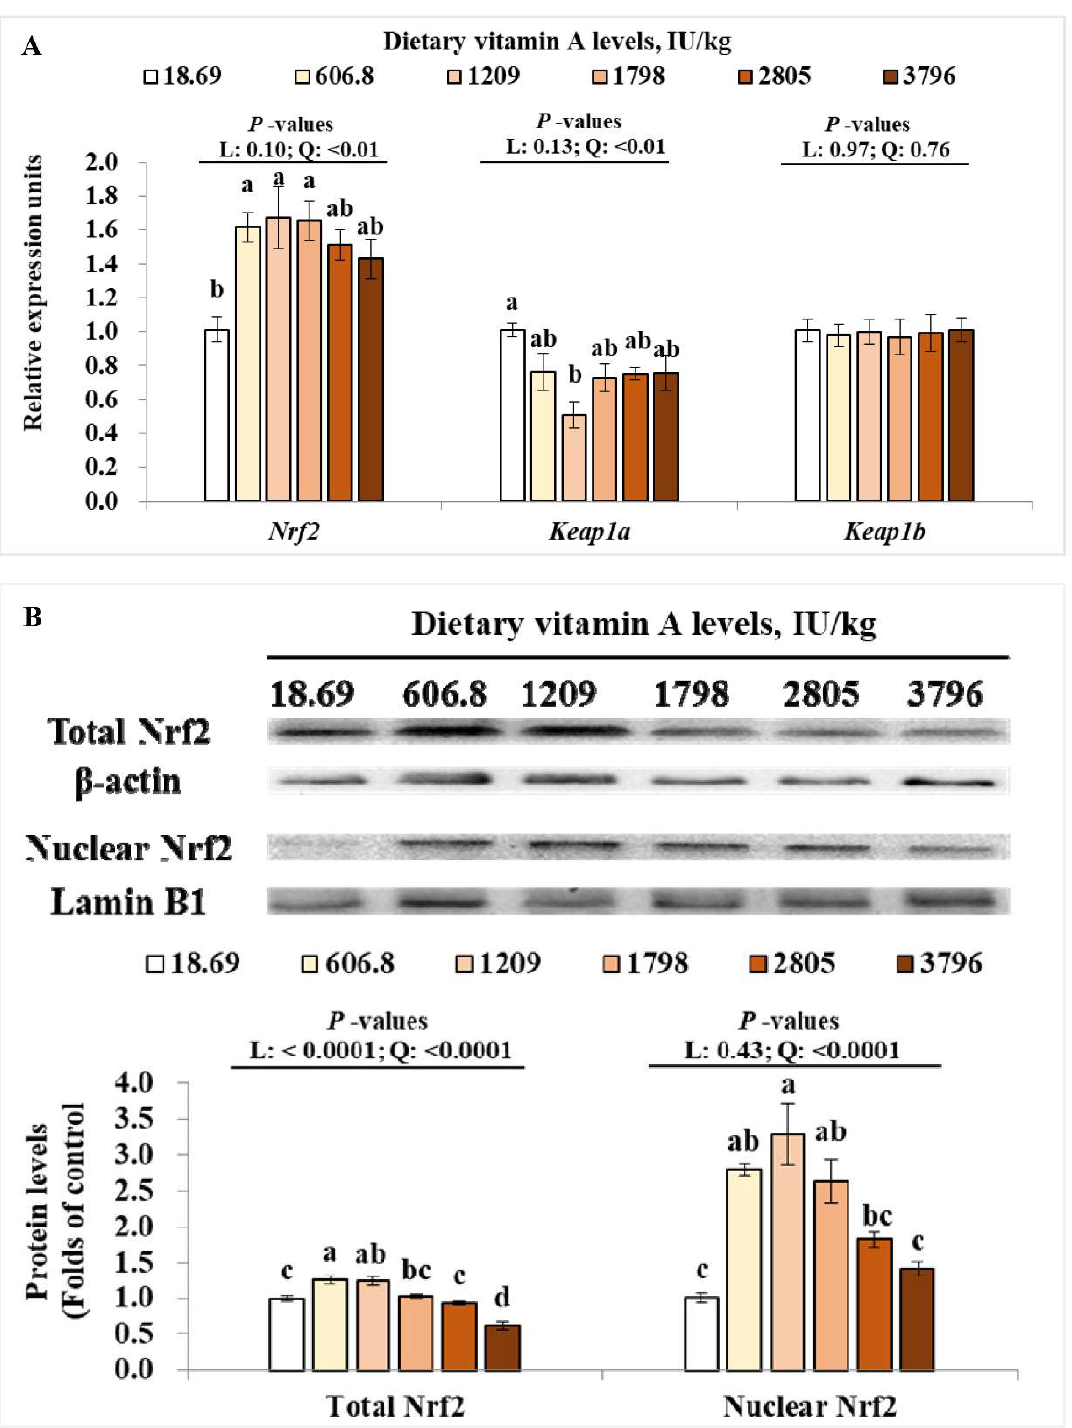
Figure 4. Effects of dietary vitamin A on relative mRNA levels of Nrf2 , keap1a, and keap1b ( A ); total and nuclear levels of Nrf2 protein ( B ) in muscle of on-growing grass carp. Data are means ± SEM of three replicate groups, two fish for each replicate ( n = 3). a,b,c,d within a column, means without a common lowercase superscript differ ( p < 0.05). p -values underlined with a solid line indicate a linear and quadratic response to dietary vitamin A levels. SEM = standard error of the mean; L = linear; Q = quadratic; Nrf2 = nuclear factor erythroid 2-related factor 2; Keap1a = Kelch-like ECH-associated protein 1a; Keap1b = Kelch-like ECH-associated protein 1b.